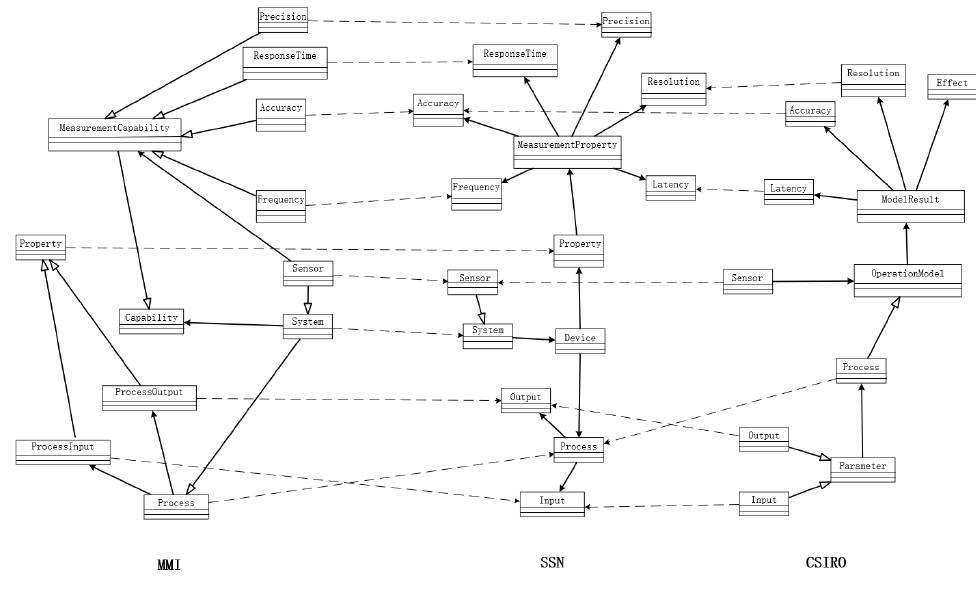
Figure 12. Small fragment of alignments between three sensor ontologies: MMI Device ontology, SSN ontology and CSIRO